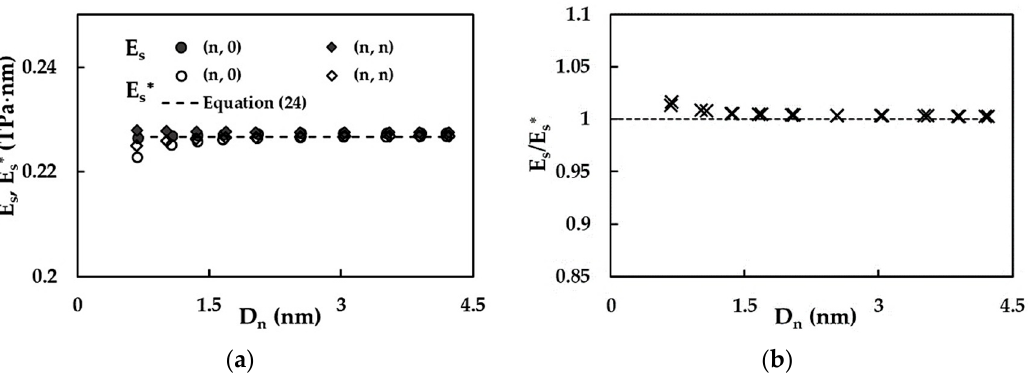
Figure 9. Evolutions of ( a ) the surface Young’s modulus, E S , and the reduced surface Young’s mod- ulus, E S* , and ( b ) the ratio E S / E S* as a function of the NT diameter, D n , for zigzag and armchair modulus, E ∗ , and ( b ) the ratio E S /E ∗ as a function of the NT diameter, D n , for zigzag and armchair S S SWSiCNTs (Table 2). SWSiCNTs (Table